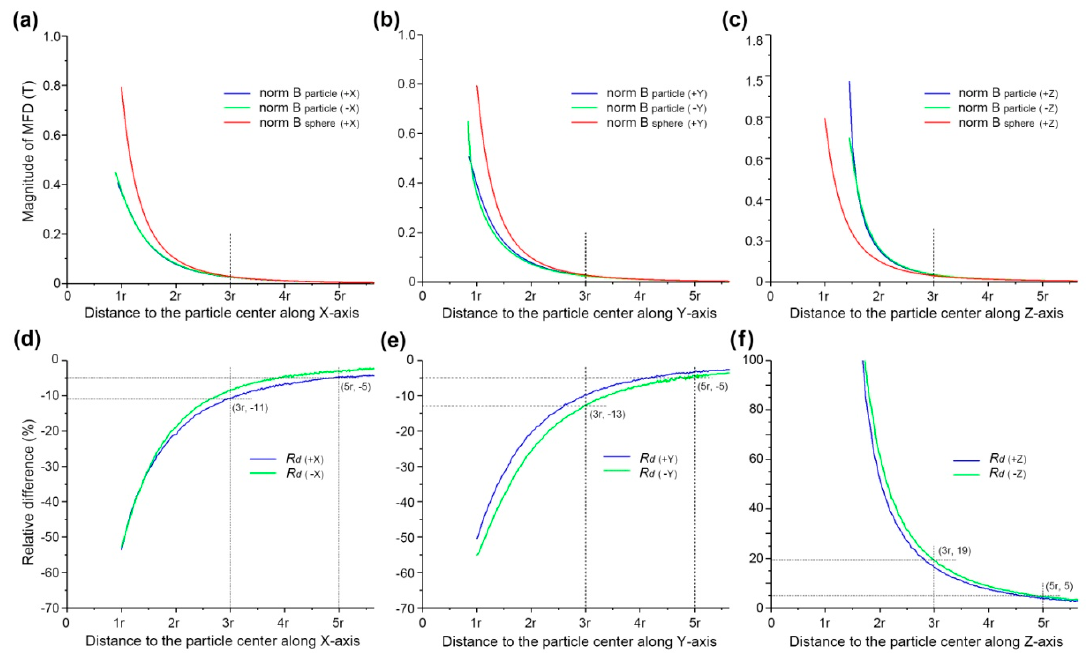
Figure 3. MFD characteristics of an irregular magnetic particle. ( a – c ) magnitude of MFD of magnetite particle along X, Y, and Z axes, respectively; ( d – f ) relative difference between magnitude of particle MFD and sphere MFD along X, Y, Z axes, respectively. The ‘r’ used in the figures’ horizontal axis is the particle volume radius, and the abscissa initial value of any curves is for the intersection point of coordinate axis and particle surface.